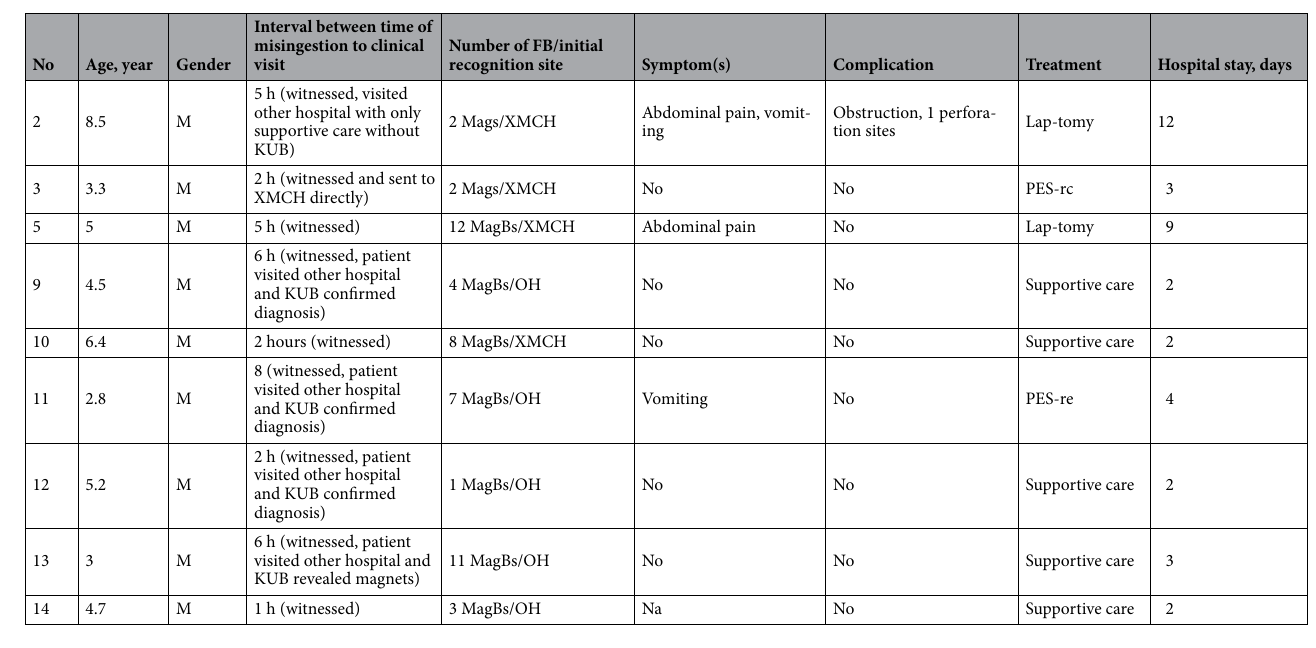
Table 2. Clinical characteristics of 9 children with witnessed/self-reported magnetic foreign body misingestion. PES-re panendoscopy retrieval.